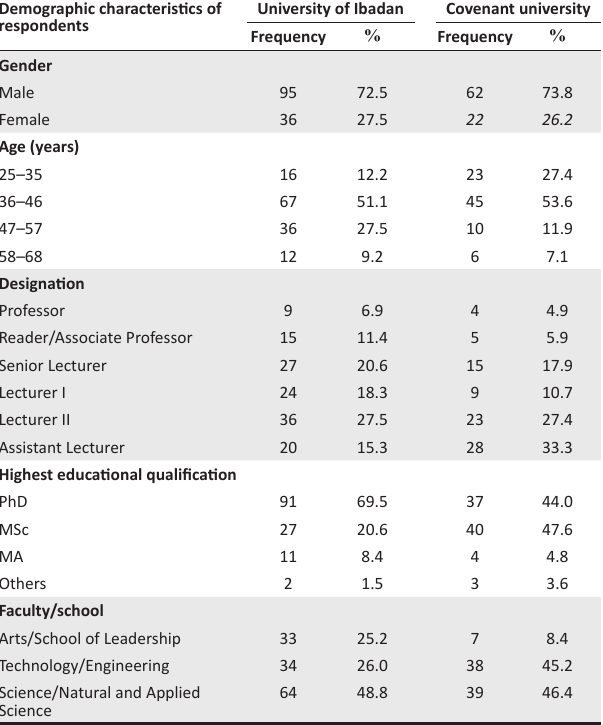
TABLE 1: Demographic characteristics of respondents ( N =